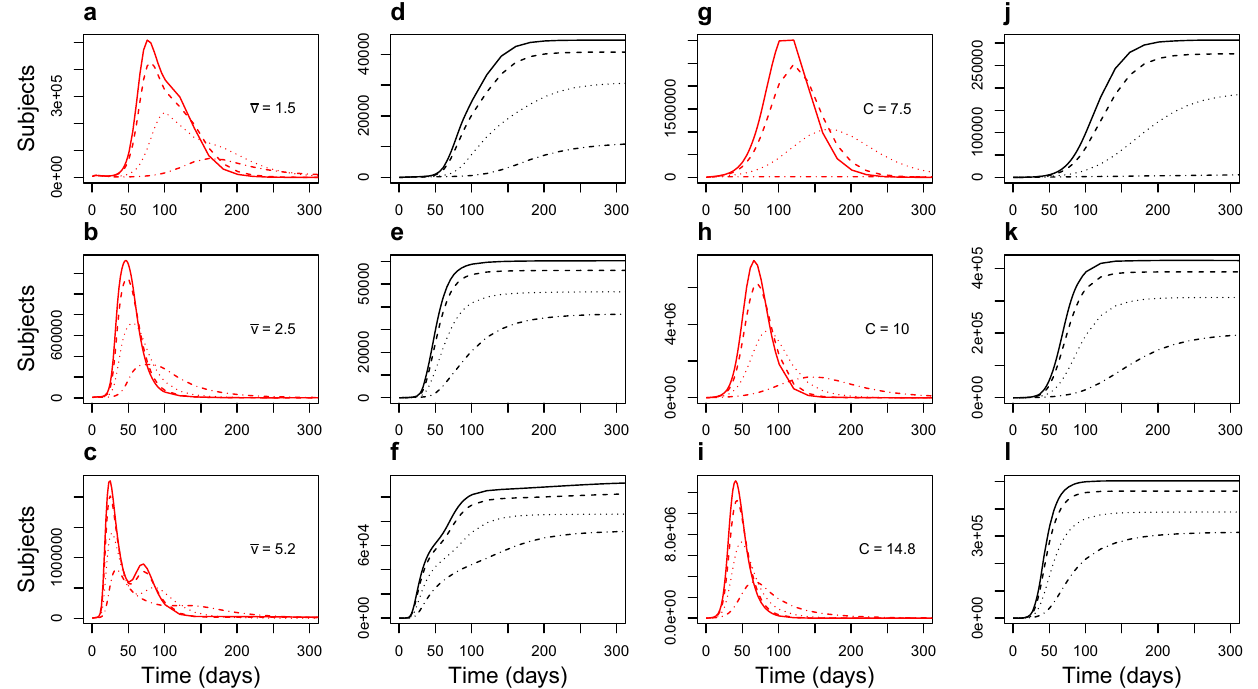
Fig. 3 Symptomatic population and mortality. Total symptomatic population (red) and simulated mortality (black) in the 48 scenarios. Density-dependent contact rate simulations on the left (plots a – f ); fi xed contact rate simulations on the right (plots g – l ). Each curve results from the sum over 110 districts averaged over 50 replicates per district. Solid lines represent no app users; dashed, dotted and dashed – dotted lines show increasing fractions of the population using the app (25, 50, 75%). All simulations can be interactively explored at https:// fl owmaps. life.bsc.es/shiny/ct_app/.